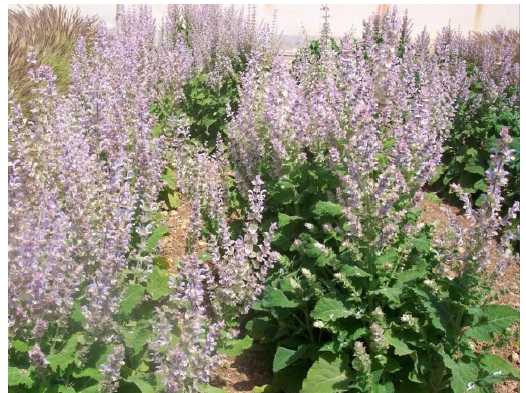
Figure 2. Plants of clary sage at full flowering stage.